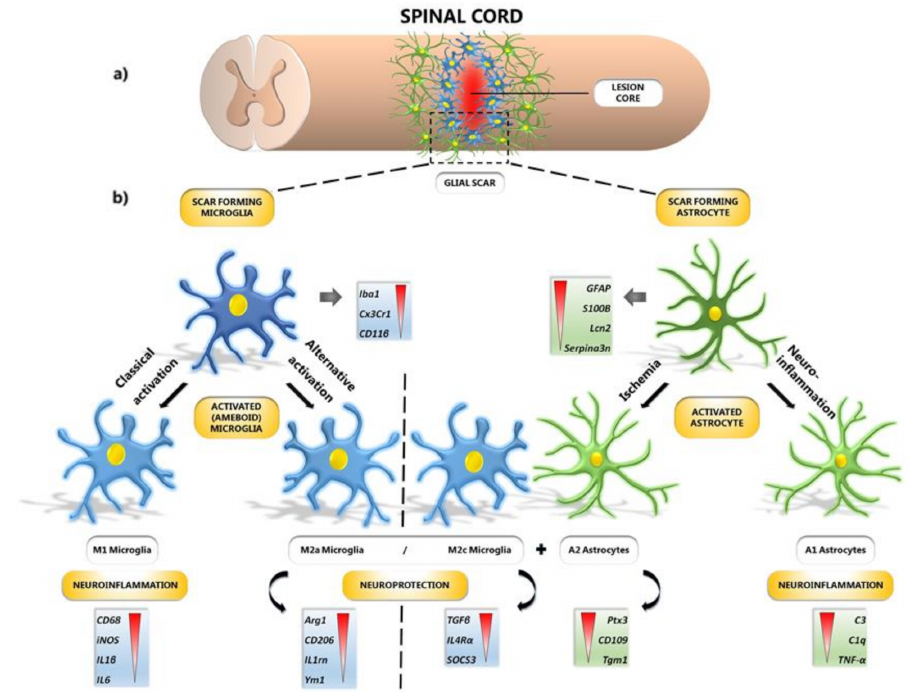
Figure 1. Formation of glial scar after SCI. ( a ) Spinal cord with illustrated lesion core surrounded by microglia and astrocytes, forming a glial scar. ( b ) Focusing on specific types of glial cells: mi- croglia and astrocytes with their corresponding genes ranked according to expression level. Resting microglia and astrocytes acquire scar-forming phenotypes through their activation under certain conditions; they differentiate into several subtypes involved either in neuroinflammation (M1, A1) or neuroprotection (M2a, M2c, A2). The M1 phenotype of microglia is acquired by classical acti- vation, whereas M2a and M2c phenotypes are acquired by alternative activation pathways. Astro- cytes, which are differentiated into A2 phenotype under ischemic conditions, promote neuronal survival and tissue repair. A1 phenotype is acquired via secretion of neuroinflammatory